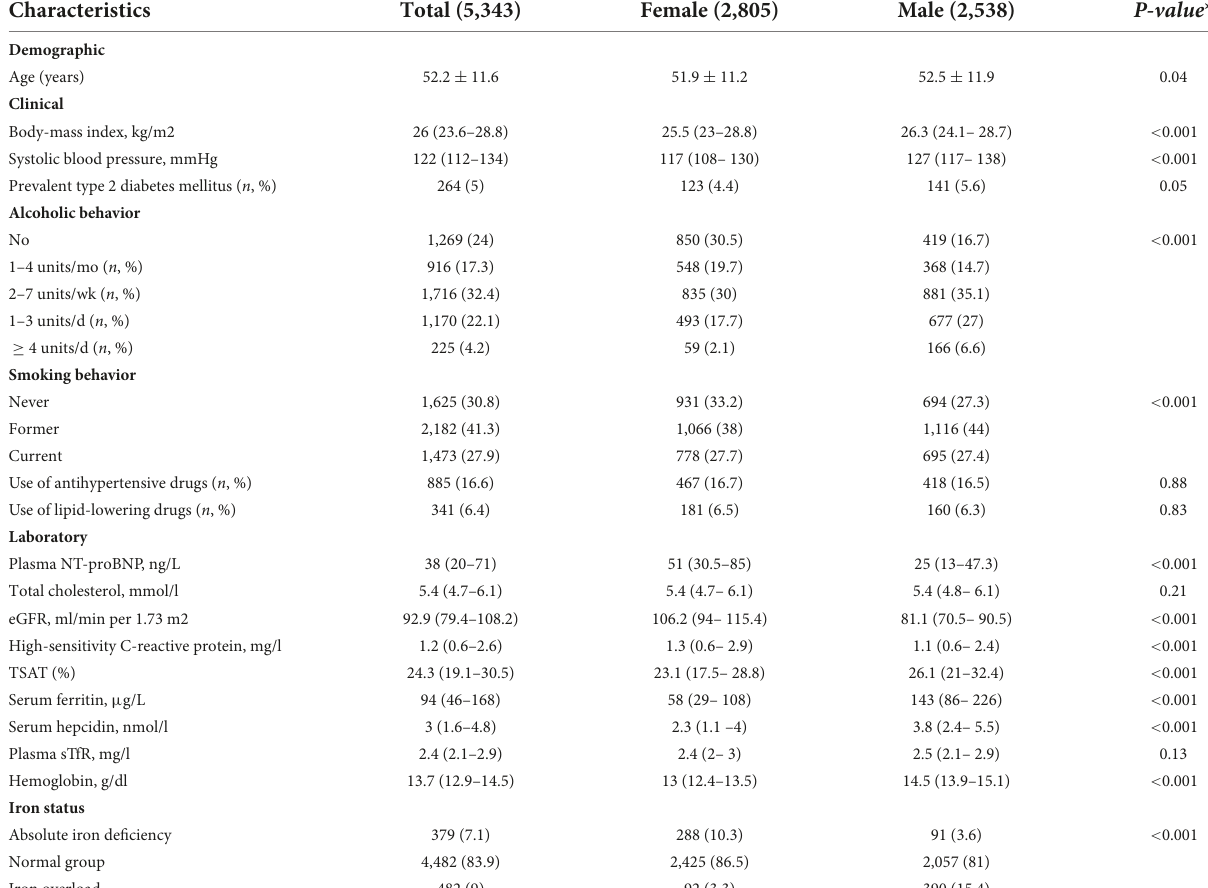
TABLE 1 Baseline characteristics of participants by sex.